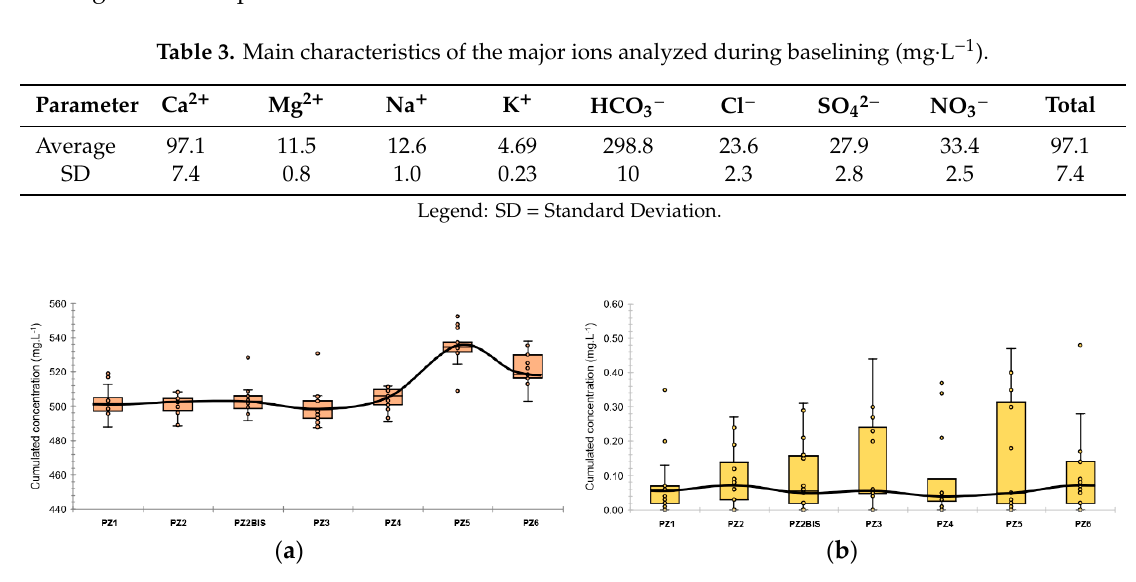
Figure 5. Boxplots of major and minor ions concentration along the experimental site during the baseline: ( a ) major elements; ( b ) minor elements. The colored boxes represent the 1st and 3rd quartiles (respectively Q1 and Q3), the black line is the median line, the dots are the measured values, the whiskers are the upper and lower extreme limits calculated according to the Tukey’s formula: Q1 + 1.5 (Q3 − Q1) and Q3 − 1.5 (Q3 − Q1).